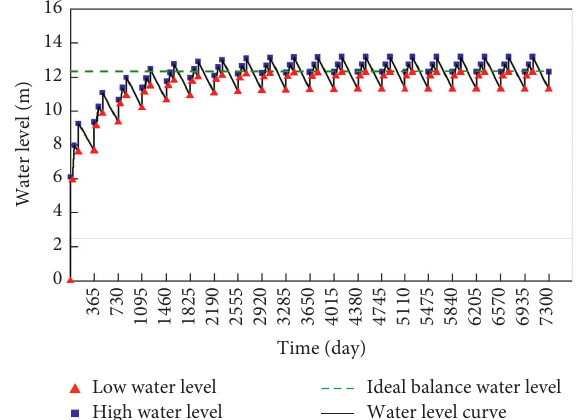
Figure 11: Water level fluctuation of mixed rainfalls entering reservoir under intermediate conditions each year.